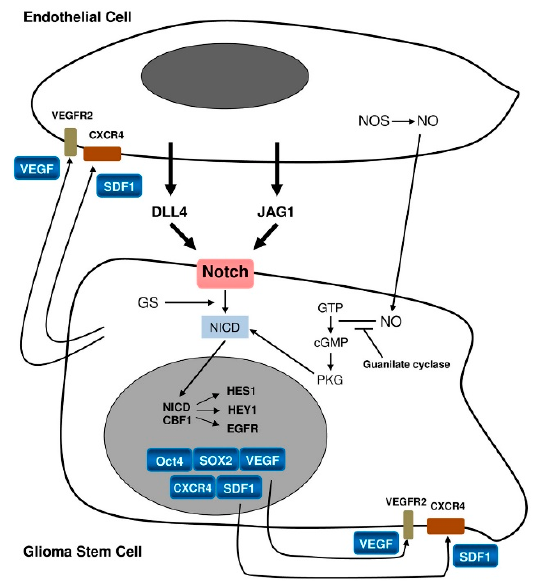
Figure 4. Relationship between a stem cell/progenitor and an endothelial cell [13].